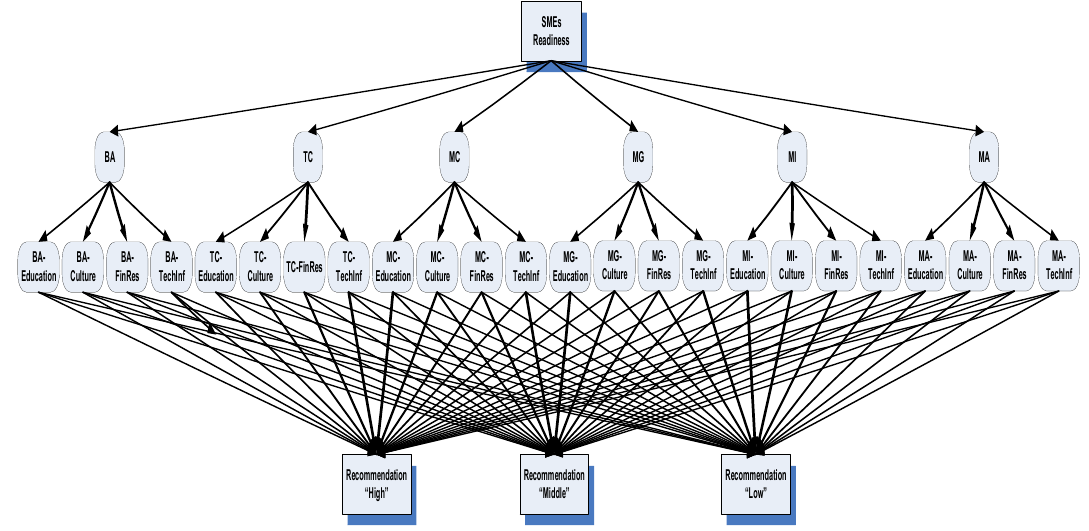
Fig. 4. The hierarchical structure of SMEs readiness model towards digital business